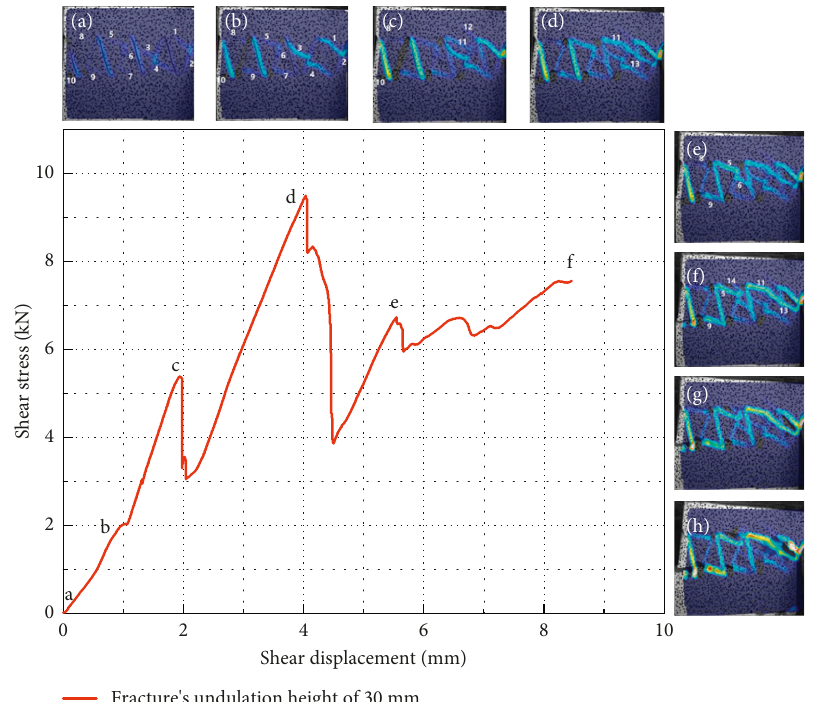
Figure 5: Shear stress-shear displacement curve of the specimen with an undulated height of 30mm.